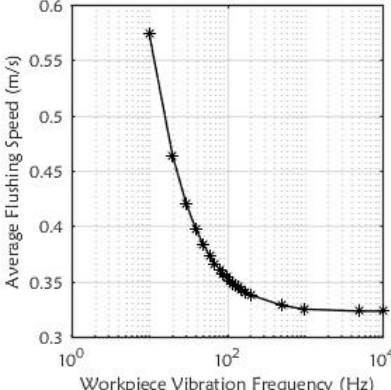
Figure 5: Effect of vibration frequency on average flushing speed at I vibration =